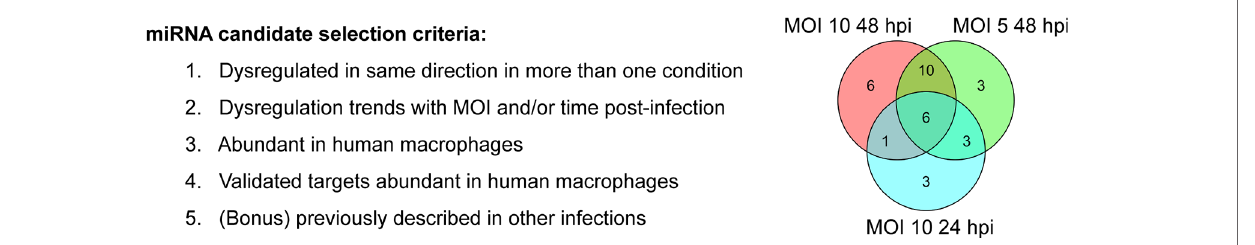
FIGURE 2 | Selection of miRNA candidates for pathway analysis. NGS analysis and literature review led to selection of 10 candidate miRNAs and their respective targets. Left) Selection criteria for candidate miRNAs. Right) Venn Diagram showing 20 differentially expressed miRNAs shared between the three conditions in which we observed the most signi fi cant miRNA dysregulation (top 3).